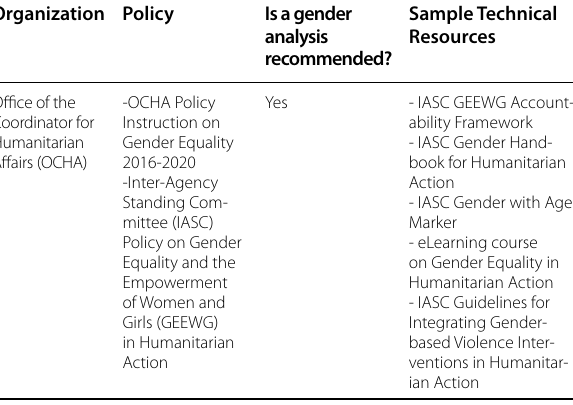
Table 7 Gender Policy, Analysis and Technical